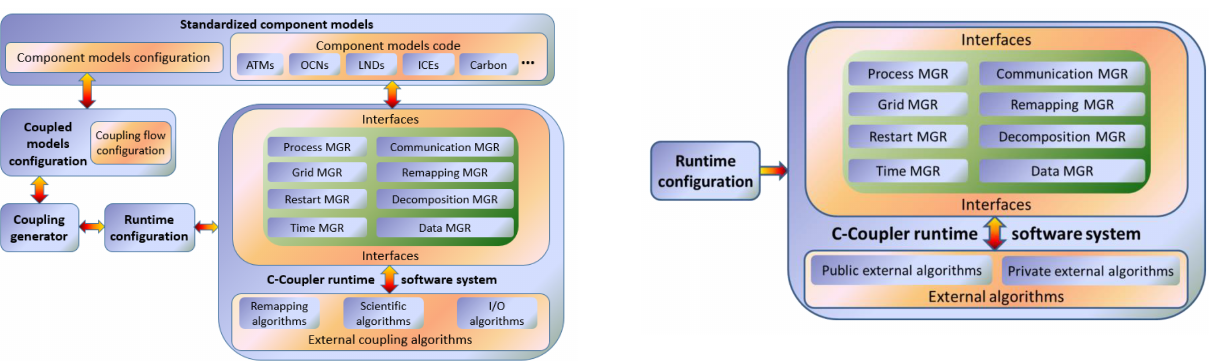
Figure 2. C-Coupler1 software